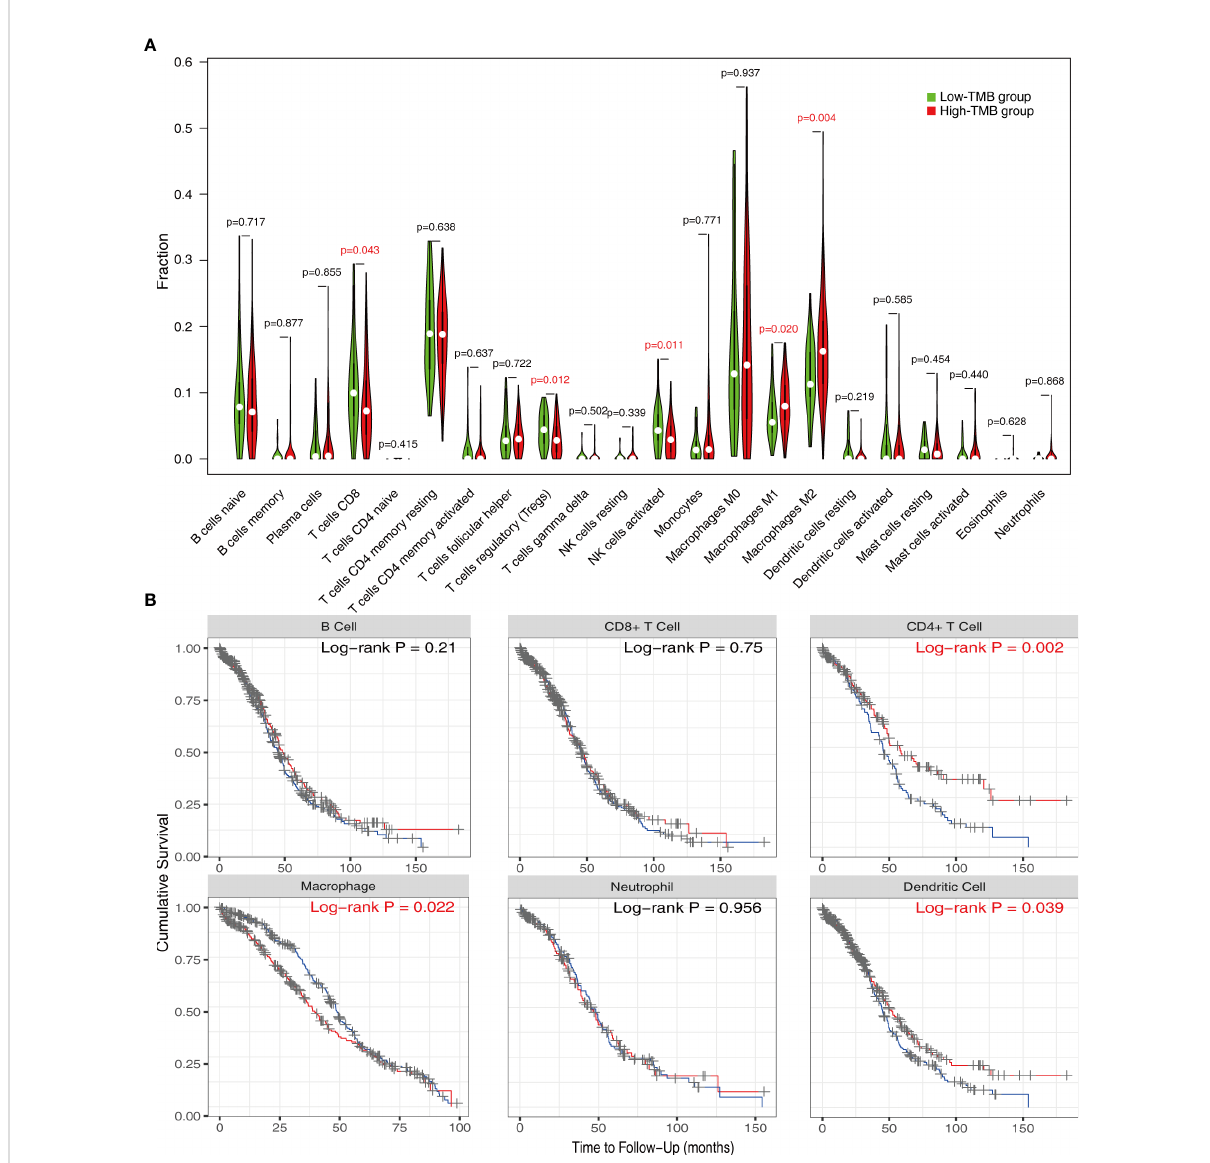
FIGURE 4 Evaluation of immune in fi ltration in the low- and high-TMB groups. (A) Comparison of abundance of 22 in fi ltrating immune cells between low- and high-TMB groups. (B) K-M analysis revealed that high in fi ltration levels of CD4+ T cells and dendritic cells and low in fi ltration levels of macrophage were associated with better survival outcomes. TMB, tumor mutational